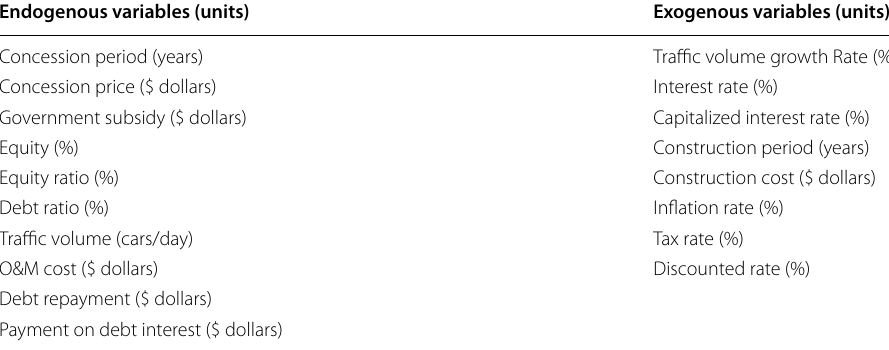
Table 2 Model variables